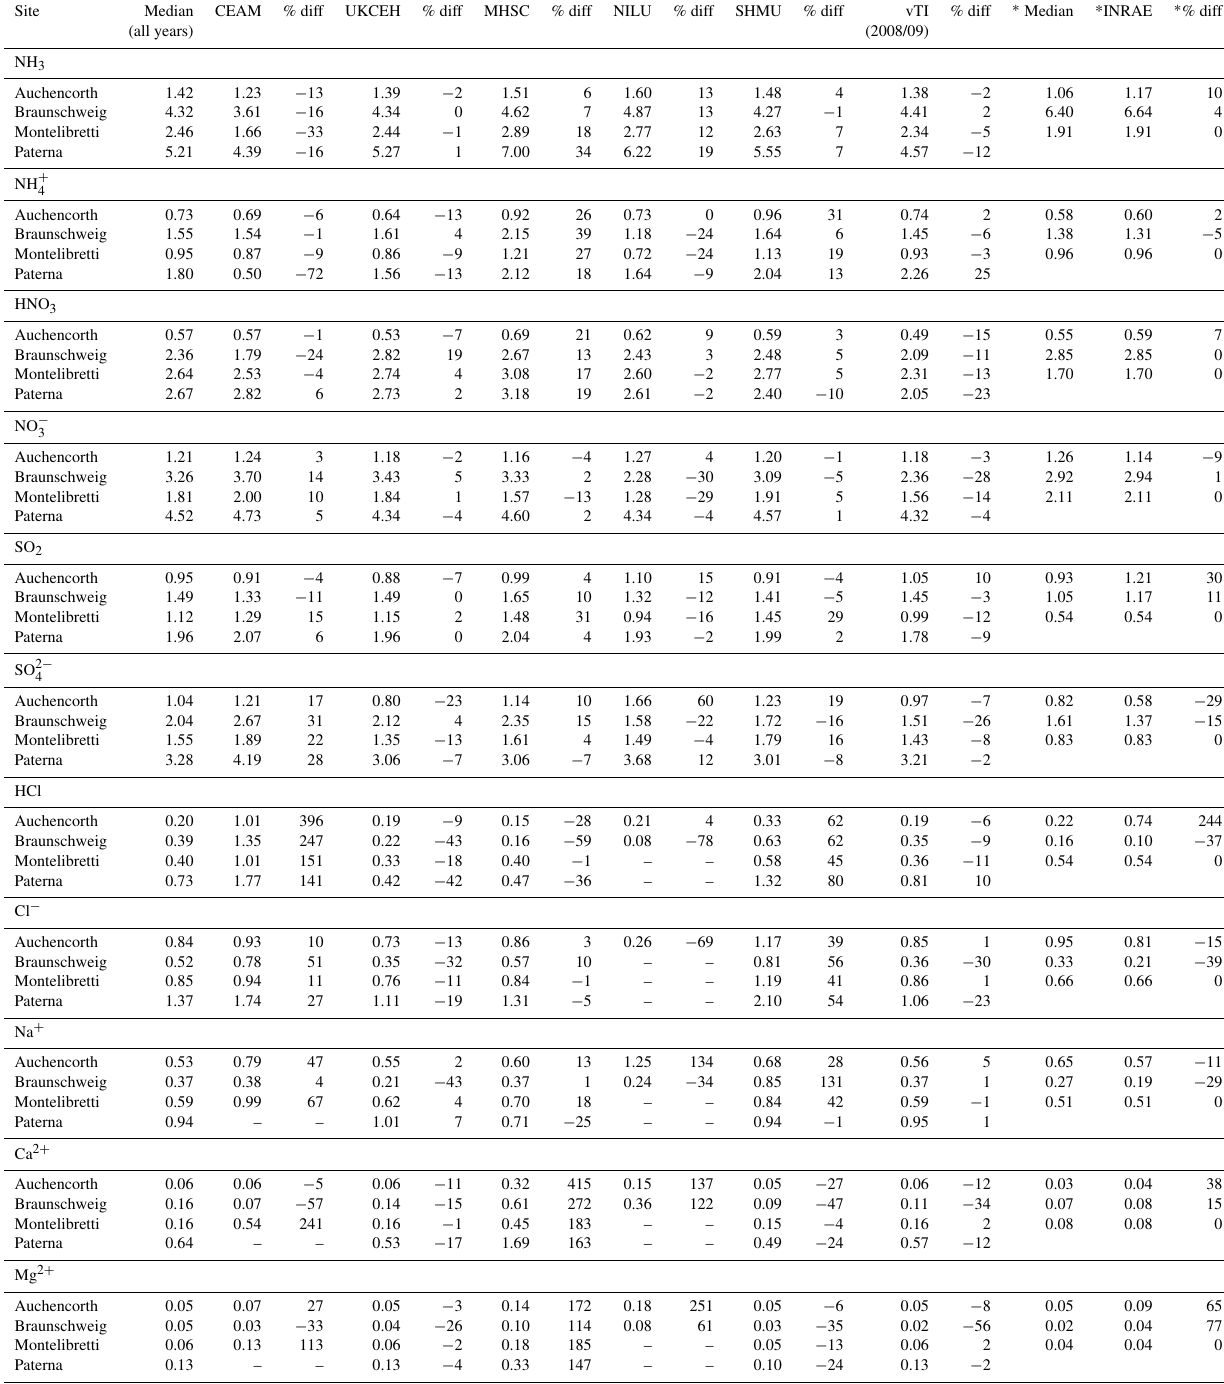
Table 2. Inter-comparison of results from seven European laboratories at four different field test sites for all years (2006–2010). The results shown are the mean concentrations from each laboratory for each site and the averaged median estimates derived from all laboratories for each